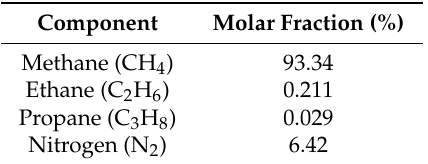
Table 1. Molar fraction of the natural gas components.